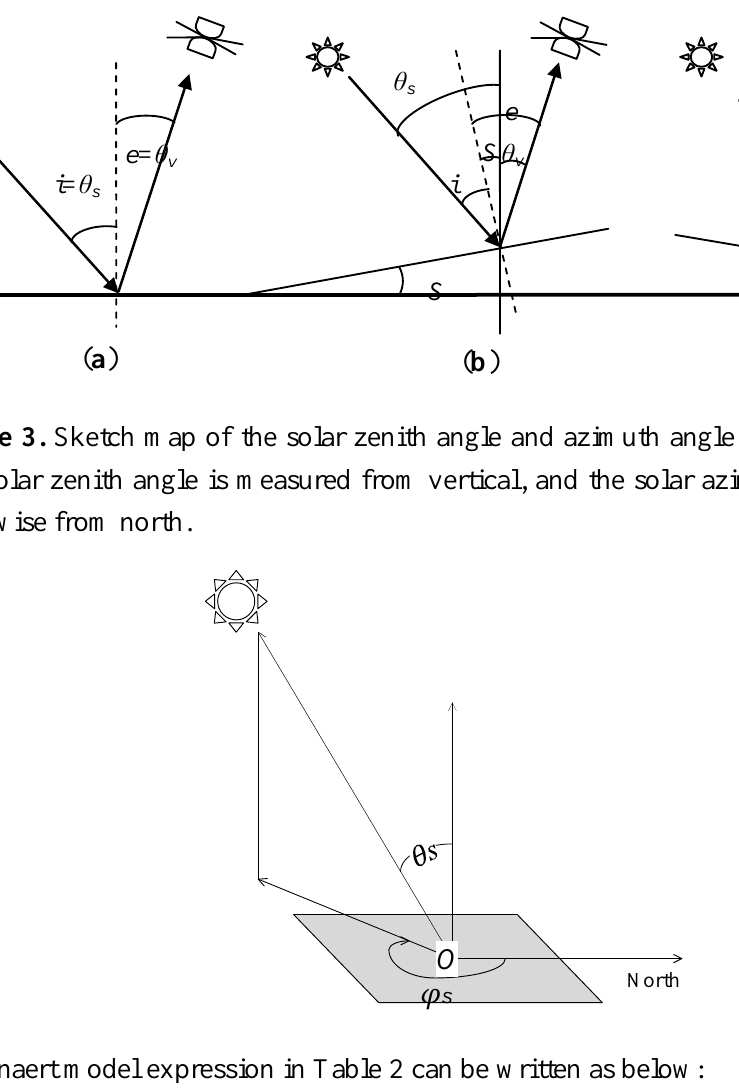
otherwise, the e equals to ( S − θ